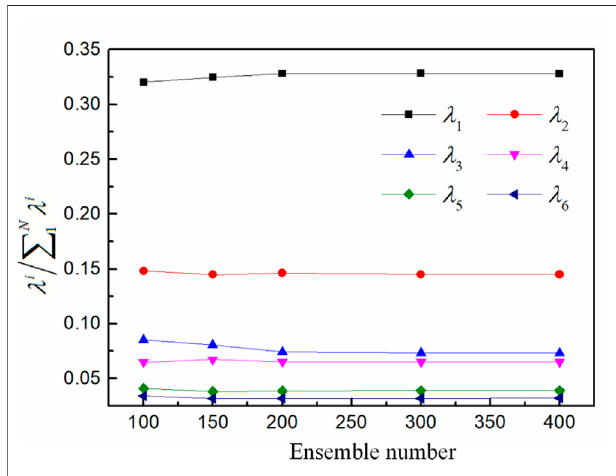
FIGURE 5 | Eigenvalue convergence as a function of ensemble